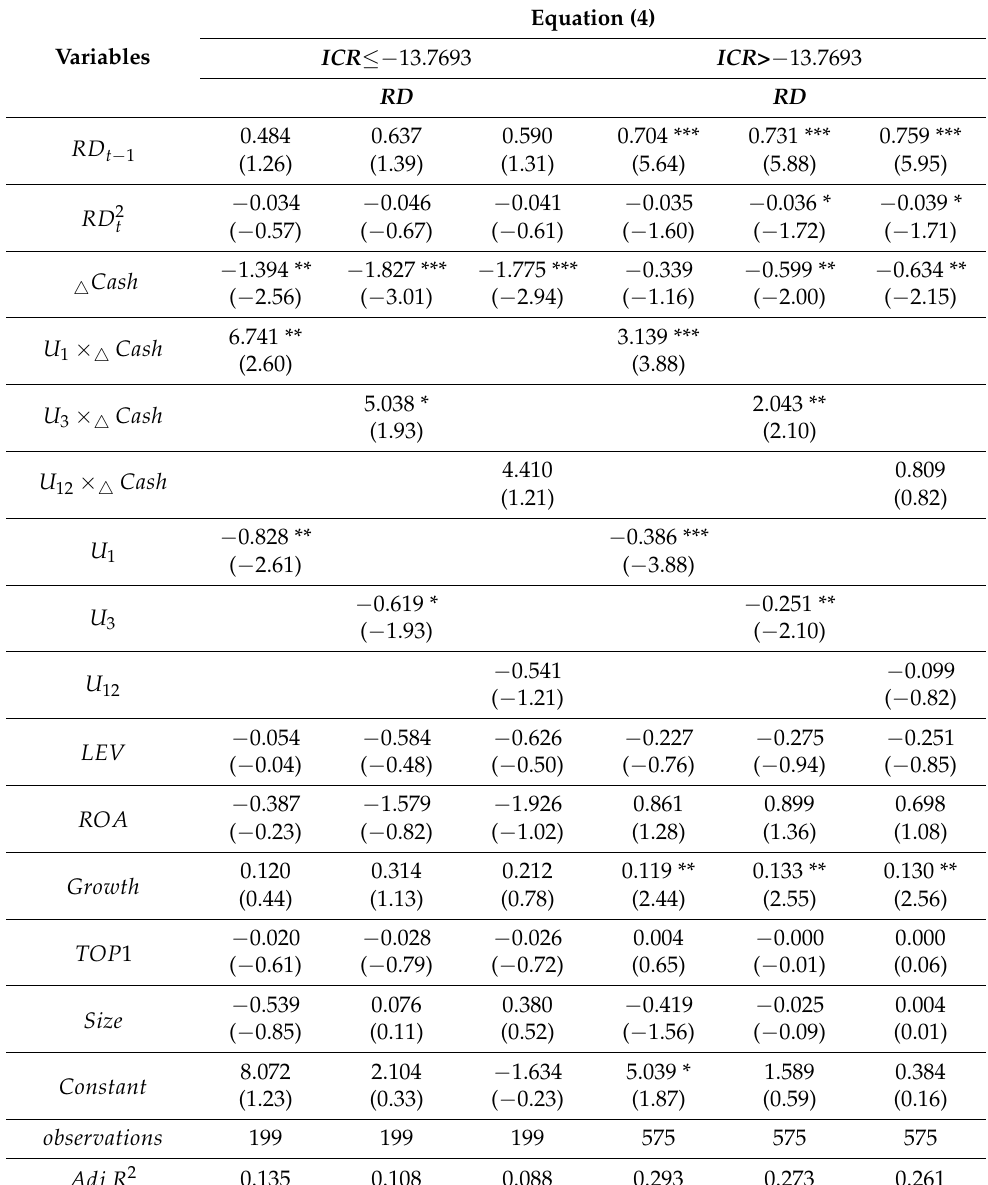
Table 8. The impact of monetary policy uncertainty on R&D investment smoothing behavior under different financing